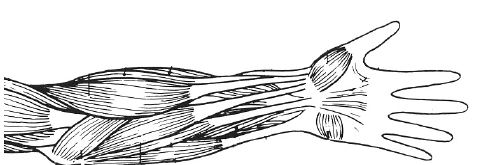
Fig. 1 Muscle structures of the forearm and hand of humans